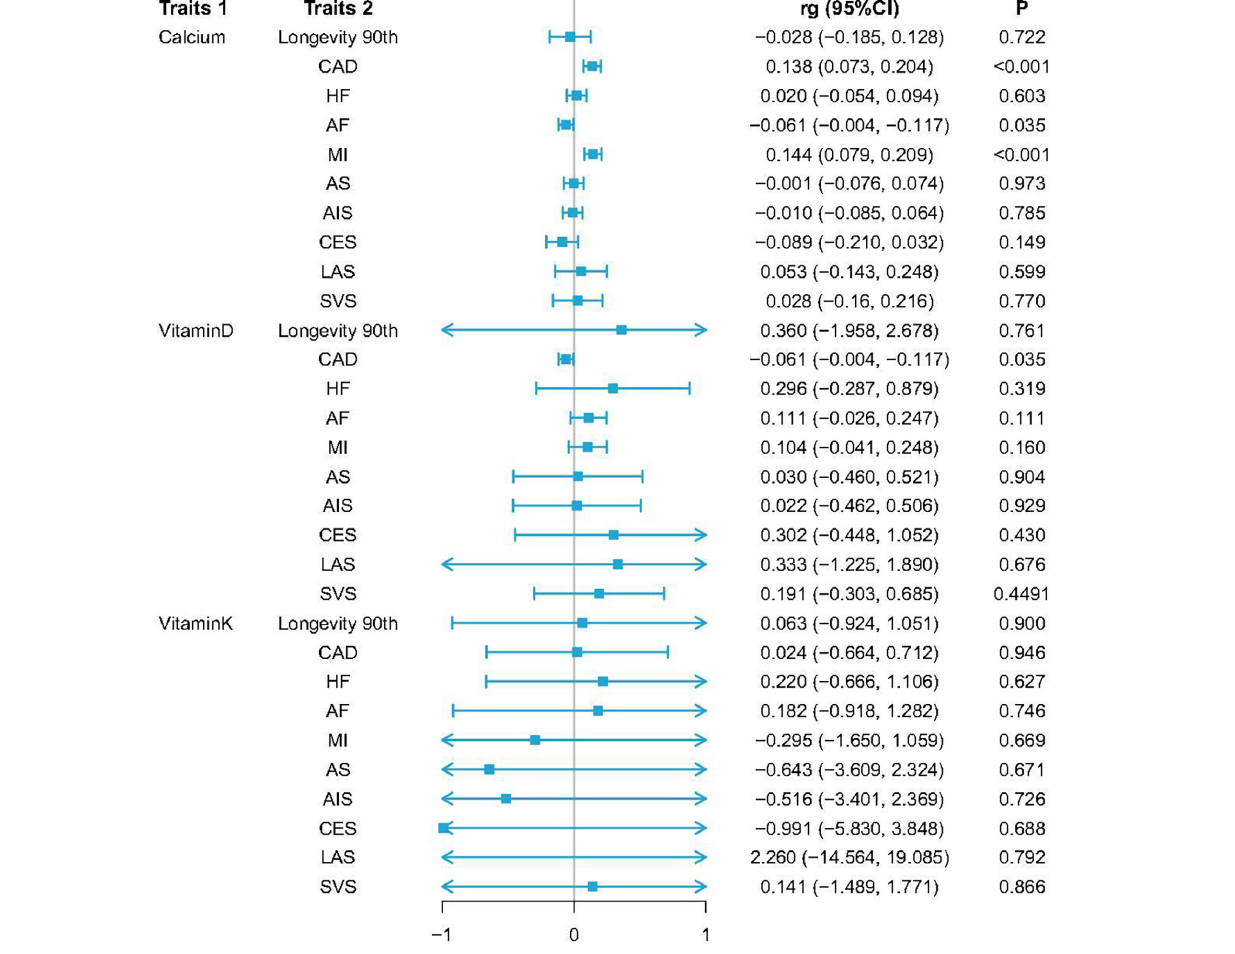
other to indicate a possible relationship between two traits.